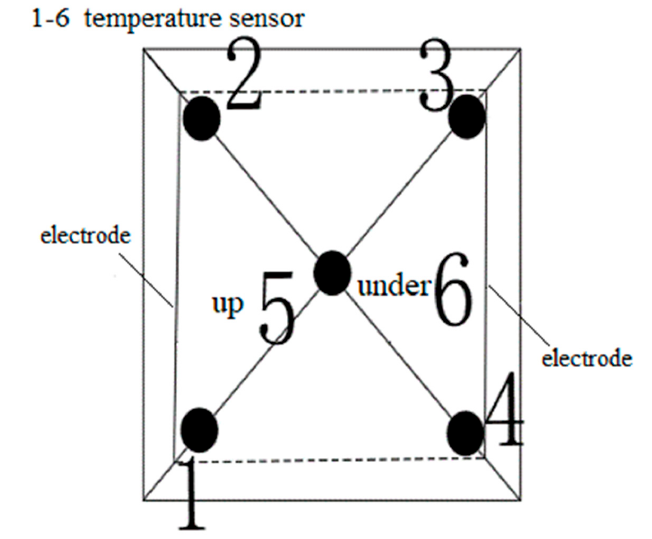
Figure 7. Left and right mesh and straight electrode layout. ( a ) mixture paving; ( b ) Surface smoothing.